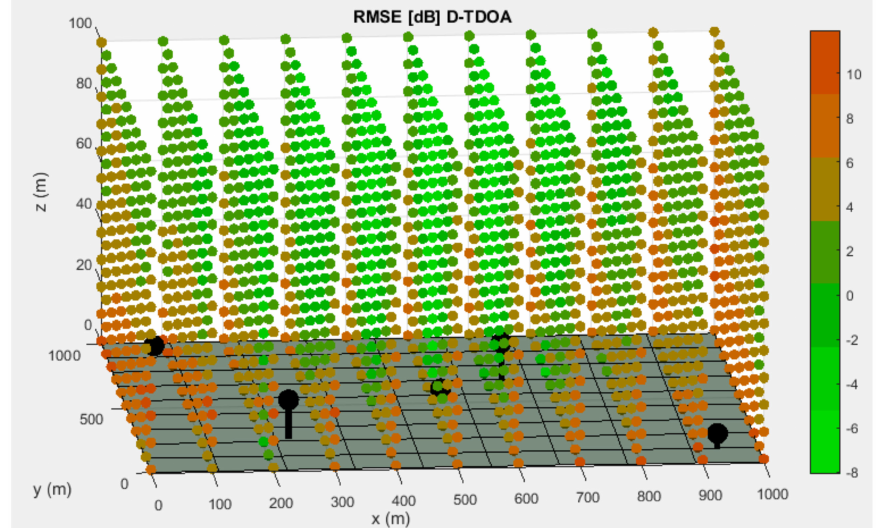
Figure 4. Best distribution of Worker Sensor (WS) and Coordinate Sensor (CS) nodes for the D-TDOA system. The base surface is presented as the grey hyperplane located at the bottom of the picture. The nodes are represented by black spheres with their correspondent holder that links them to the base surface. The CRLB evaluation of discretization points is displayed according to the right-hand side